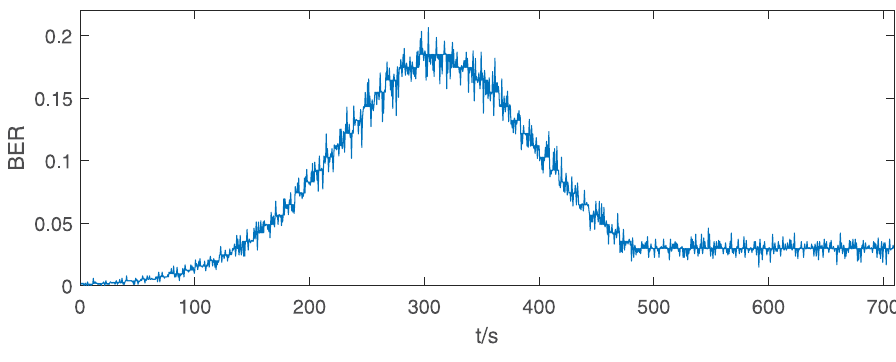
Fig 13. BER under the electromagnetic interference shown in Fig 12.